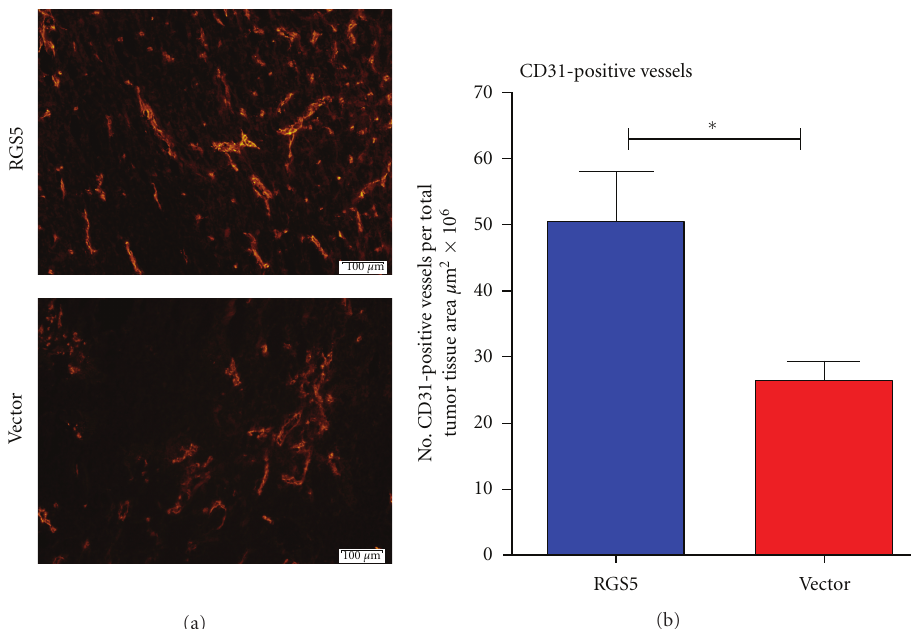
Figure 4: RGS5-expressing ovarian tumors increase the number of CD31-positive vessel-like structures. Tumor specimens were sectioned and prepared on slides for immunofluorescence. (a) Tumor sections were imaged for CD31 expression (red, 20x magnification). (b) CD31- positive vasculature was quantified from compiled whole tumor images ( N = 4 vector, N = 4 RGS5) using CellSens and GraphPad Prism software. ∗∗ P < 0 . 01, comparing vector versus